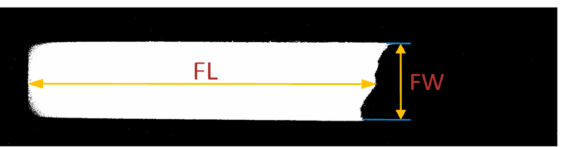
Figure 6. The flow properties–length and width as obtained from the binary map.